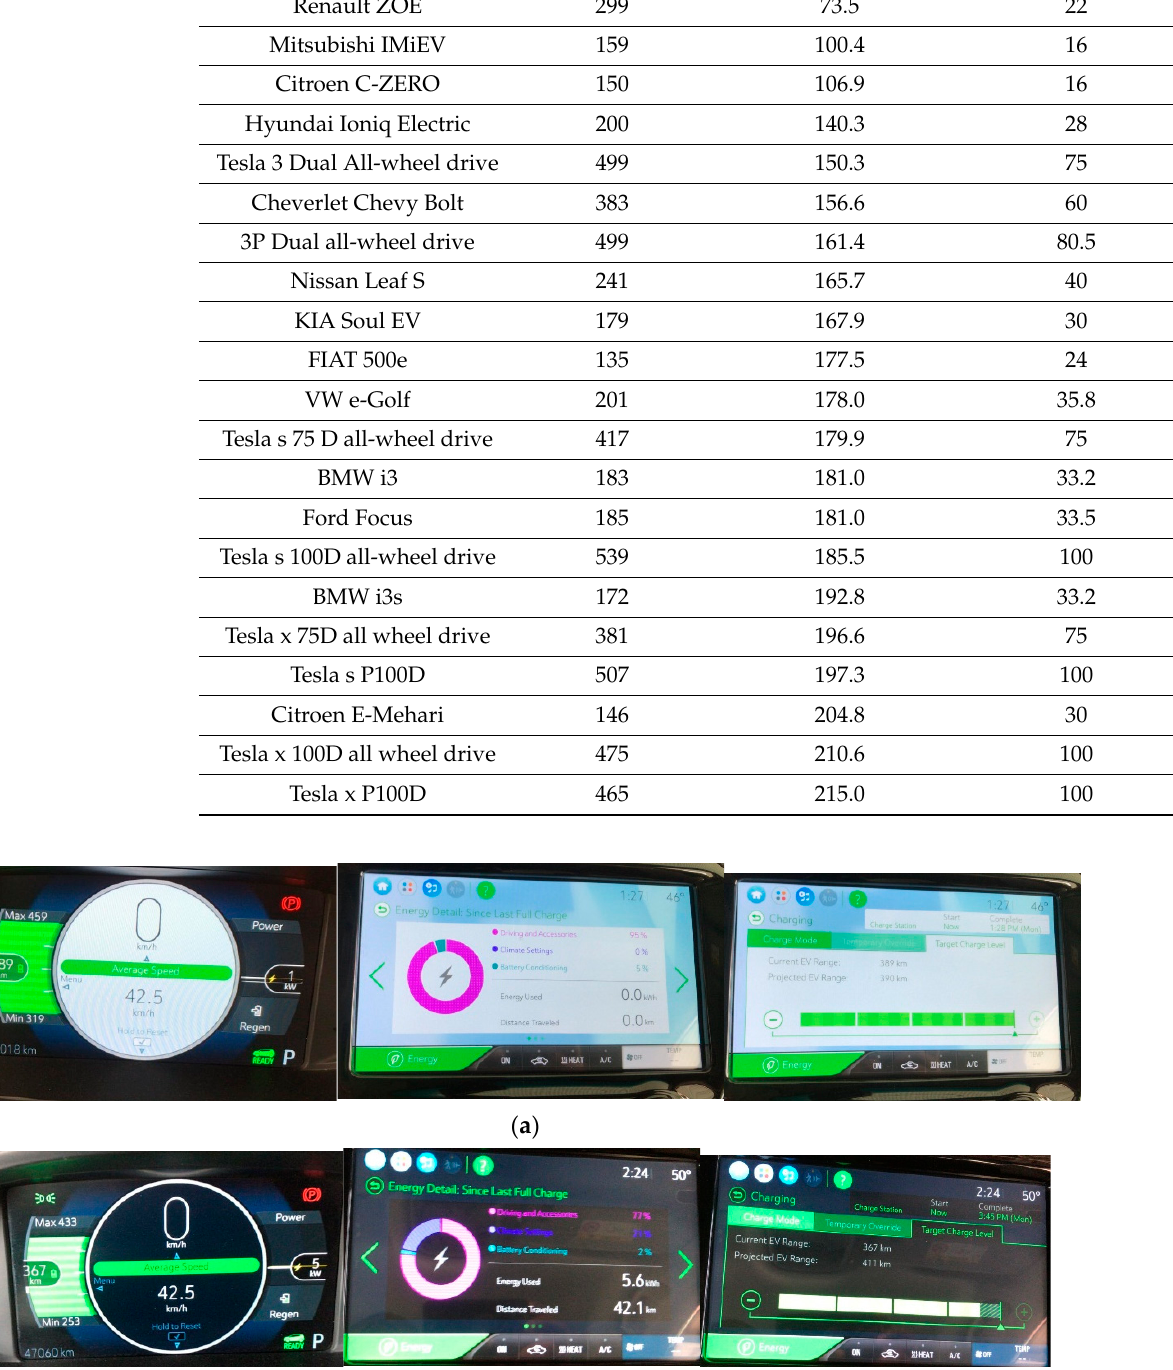
Table 2. Data collection from EV.